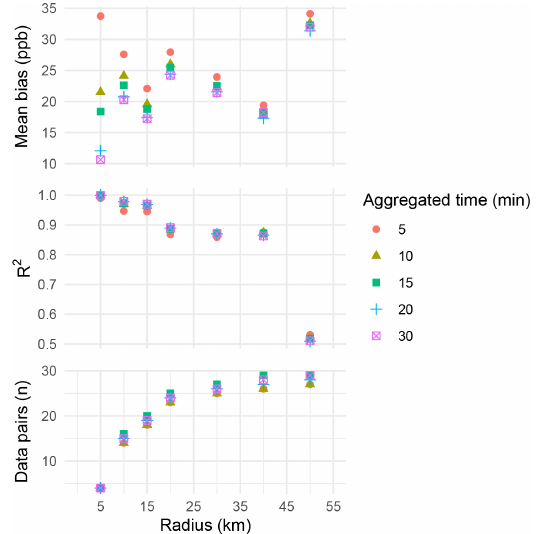
Figure D1. Results from the sensitivity analysis between the EM27/SUN and TROPOMI with a varying radius away from mea- surement site and varying aggregated times.